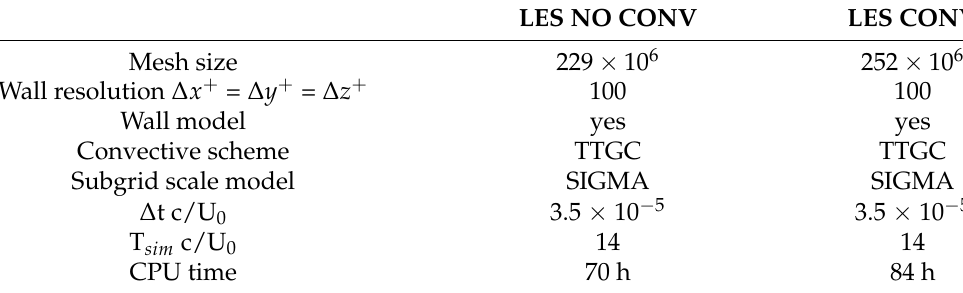
Table 1. Simulation parameters, time and cost of the two computational domain approaches.